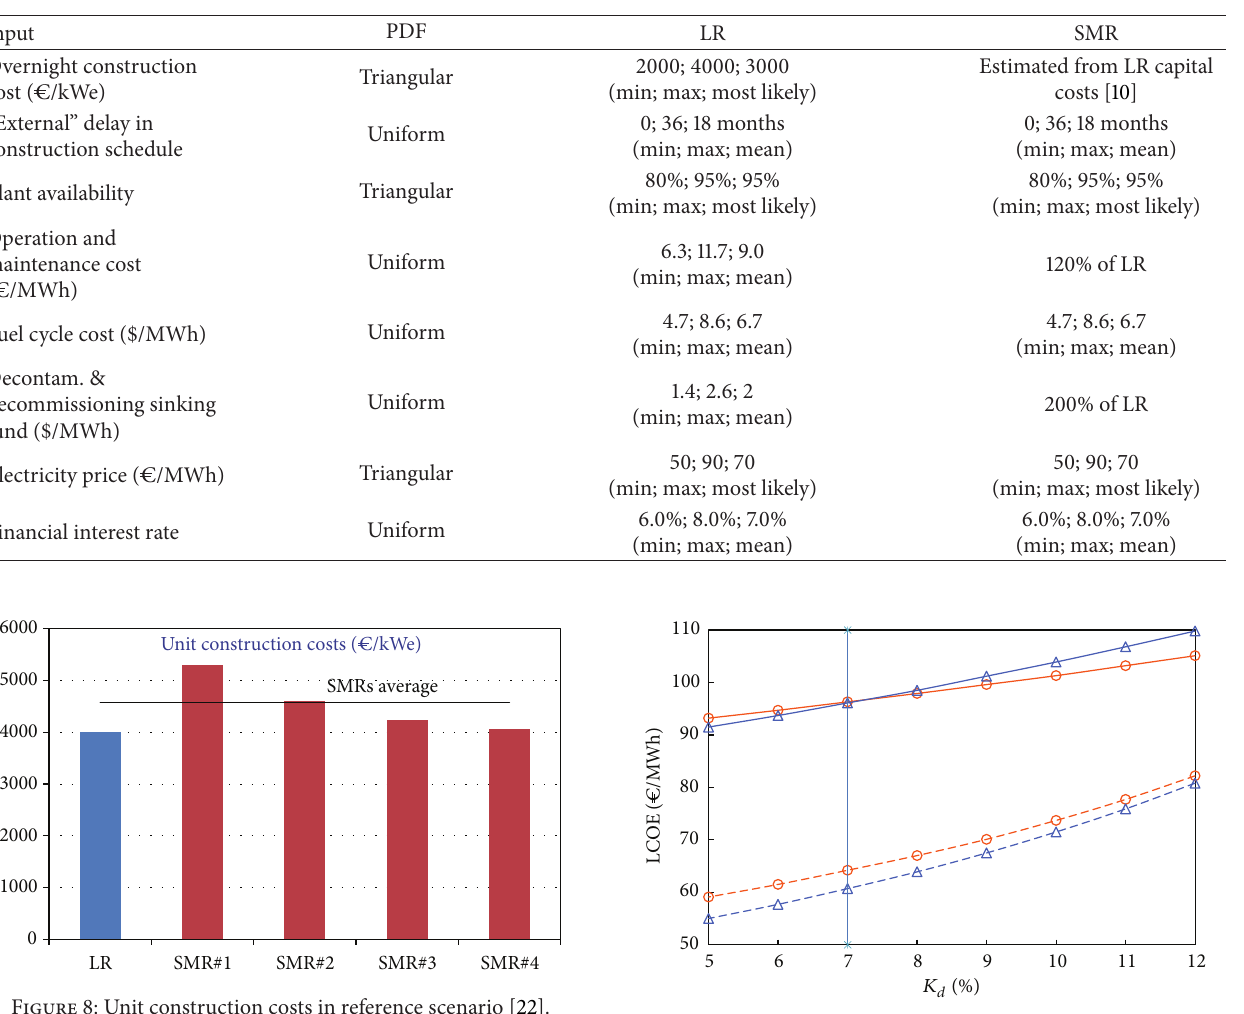
Figure 8: Unit construction costs in reference scenario [22].